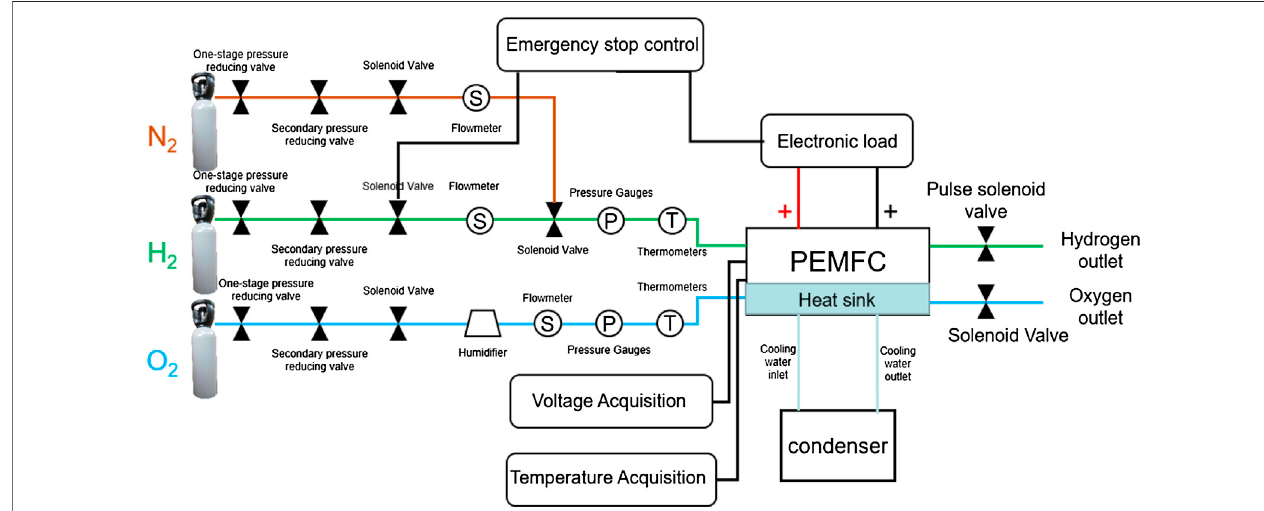
FIGURE 1 | Diagram of full dead-ended proton exchange membrane fuel cell test system.